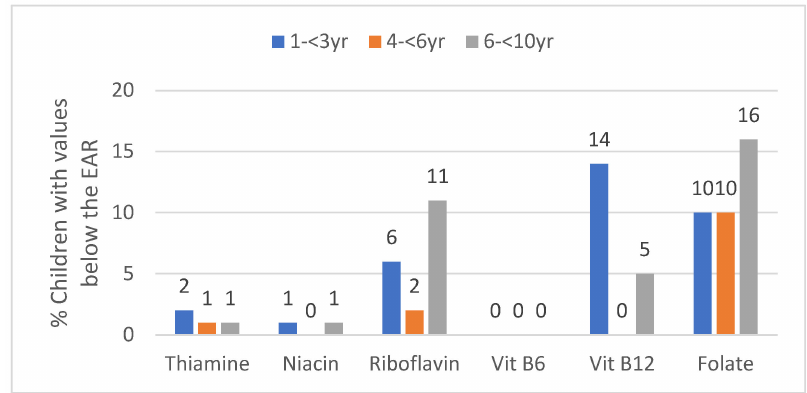
Figure 4. Percent children in the three age groups with values below the estimated average requirement (EAR) for B vitamins (taken to nearest